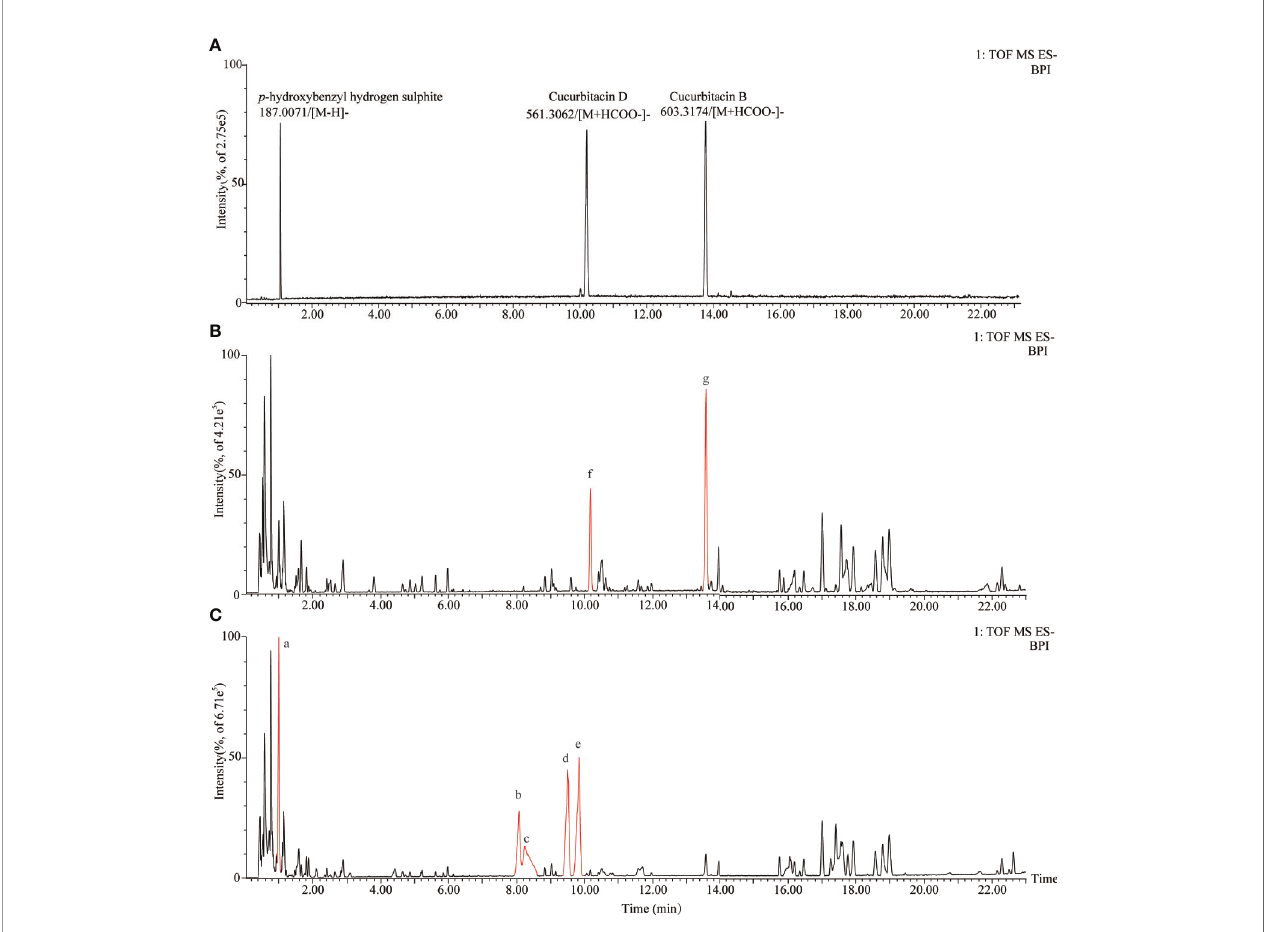
FIGURE 1 | Total ion chromatograms of TR extraction for sulfur-fumigated prior to fumigation and after 1 h in negative mode. (A) Total ion chromatograms of p - Hydroxybenzyl hydrogen sul fi te, cucurbitacin B, and cucurbitacin D. (B) Total ion chromatograms of non-fumigated TR extraction. (C) Total ion chromatograms of sulfur-fumigated TR extraction; Compounds a and g are sulfur-fumigation markers in TR